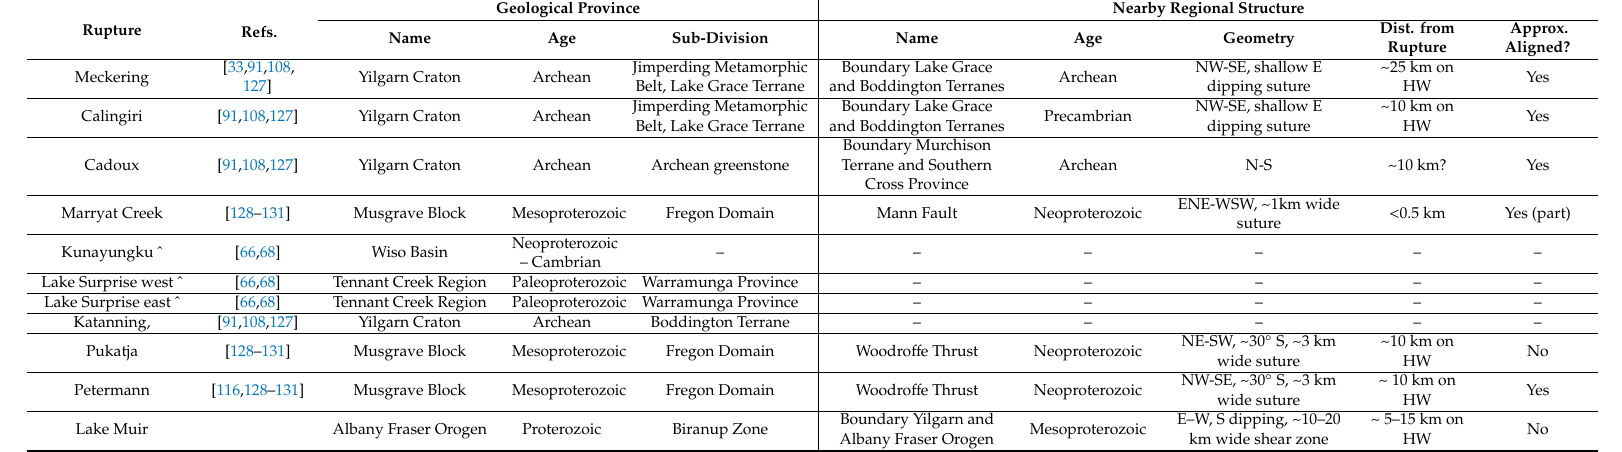
Table 3. Summary of regional geology for each historic surface